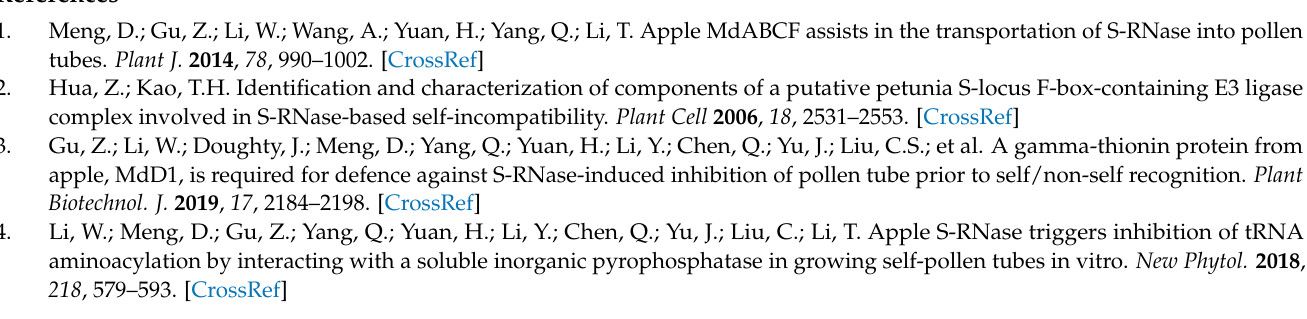
RNase, Figure S2: The heat map representation of genes involved in the polyamine metabolic pathway, Figure S3: Relative expression of selected DEGs in pollen tubes treated with self-S-RNase and in pollen tubes treated with self-S-RNase with added 0.25 exogenous spermidine, Table S1: Polyamine metabolism pathway gene information, Table S2: Primers used in this study, Table S3: RNA-Seq data statistics. Table S4. Oligodeoxynucleotide